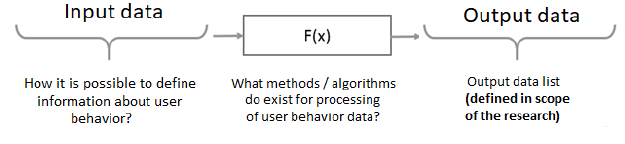
Fig. 1. Definition of the research question of this paper